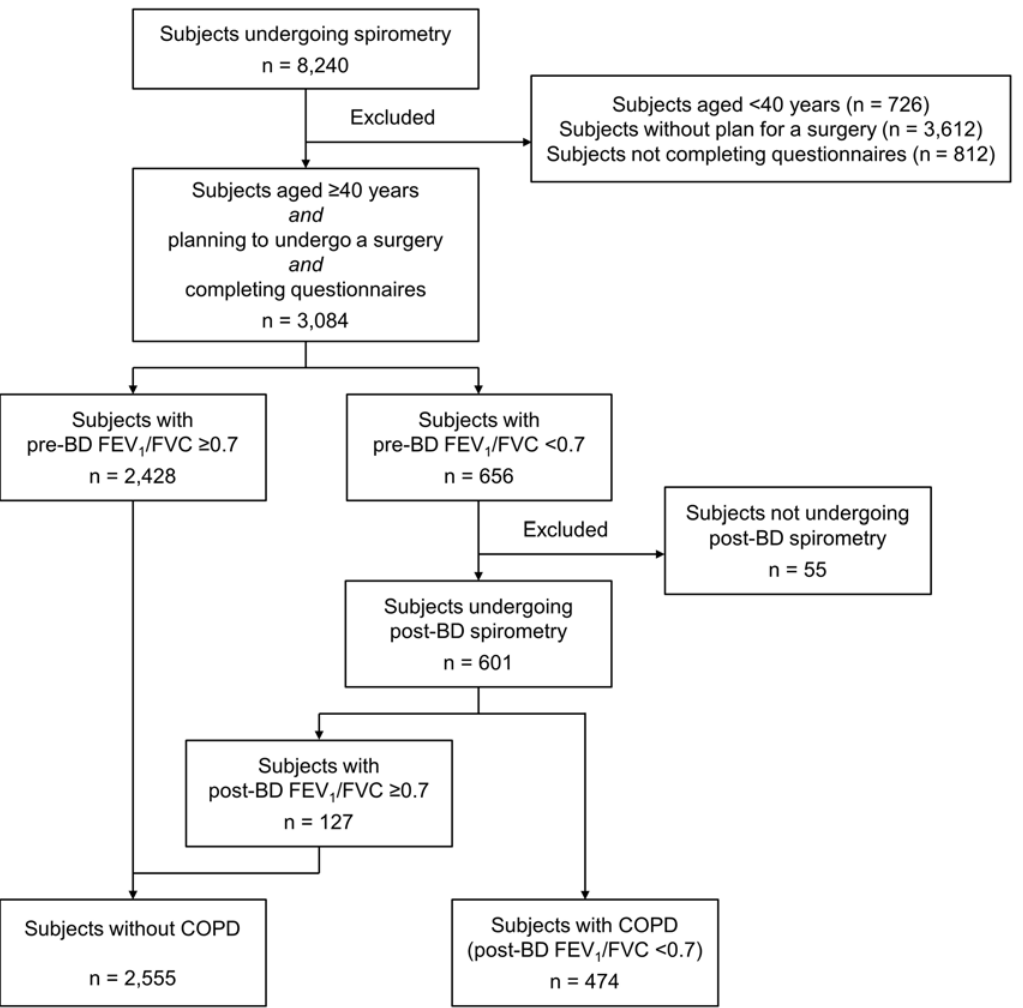
Fig 1. Selection of subjects for the analysis of COPD prevalence among surgical candidates. BD: bronchodilator, FEV1/FVC: forced expiratory volume in 1 s/forced vital capacity, COPD: chronic obstructive pulmonary disease.